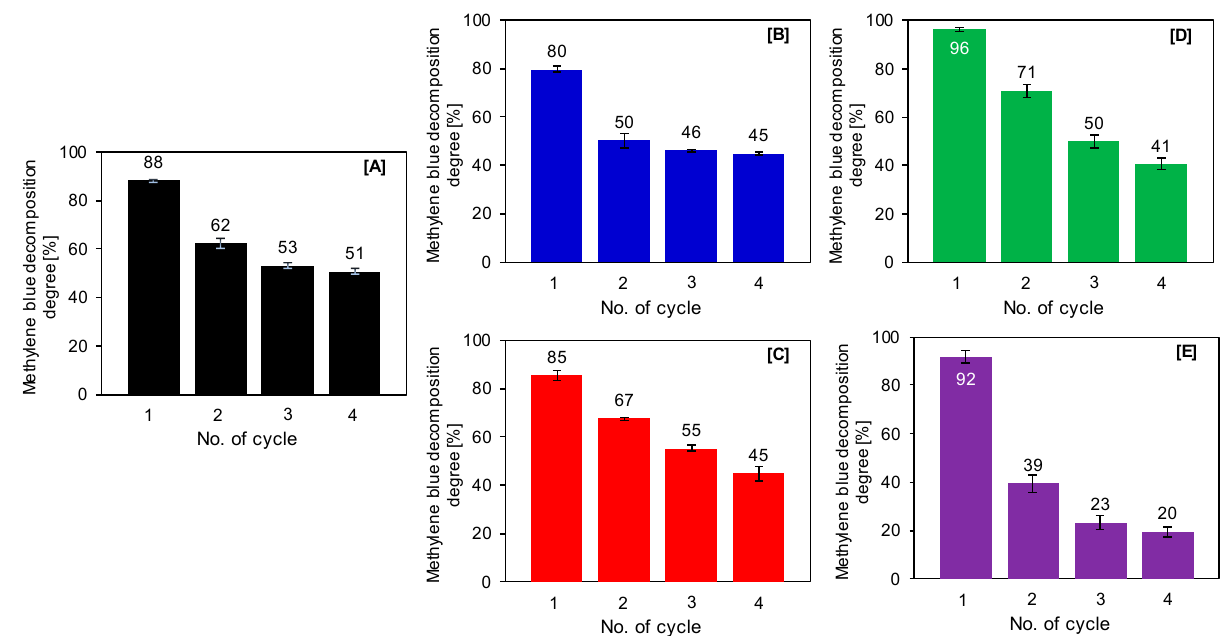
Figure 11. Photocatalytic activity in subsequent cycles of methylene blue degradation of TiO 2 –4h–120°C–500mM ( A ), TiO 2 –4h–120°C–500mM-Ar-300°C ( B ), TiO 2 –4h–120°C–500mM-Ar-500°C ( C ), TiO 2 –4h–120°C–500mM-Ar–700°C ( D ), and TiO 2 –4h–120°C-500mM-Ar-900°C ( E ) materials.